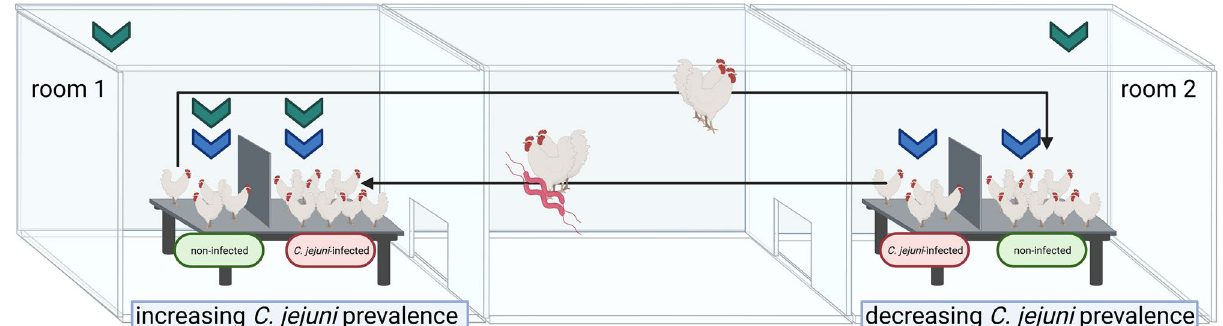
Figure 1. Chickens were kept in two rooms under special biosafety measures in the animal facility. Every three days, two animals from each box changed rooms. The continuous wall prevented direct contact between the artificially C. jejuni -infected and non-infected birds kept in one box. Green arrows mark the positions of air sampling for VOCs analysis, which occurred twice each day. Blue arrows mark the positions of electrostatic air sampling for qPCR analysis, which ran once every day. The figure was created with http:// biore nder. stationary growth phase (24 to 48 h). An isotonic 0.9% sodium chloride solution was used as the basis for the infection bouillon. A defined density of C. jejuni was adjusted (0.5 McFarland units) using a densitometer (DEN